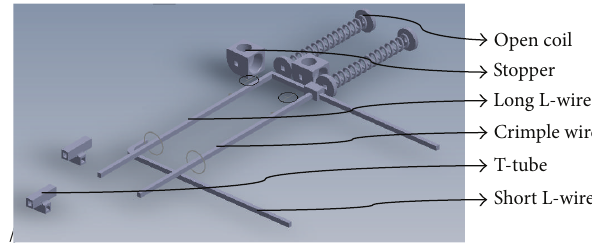
Figure 1: Components of Cise